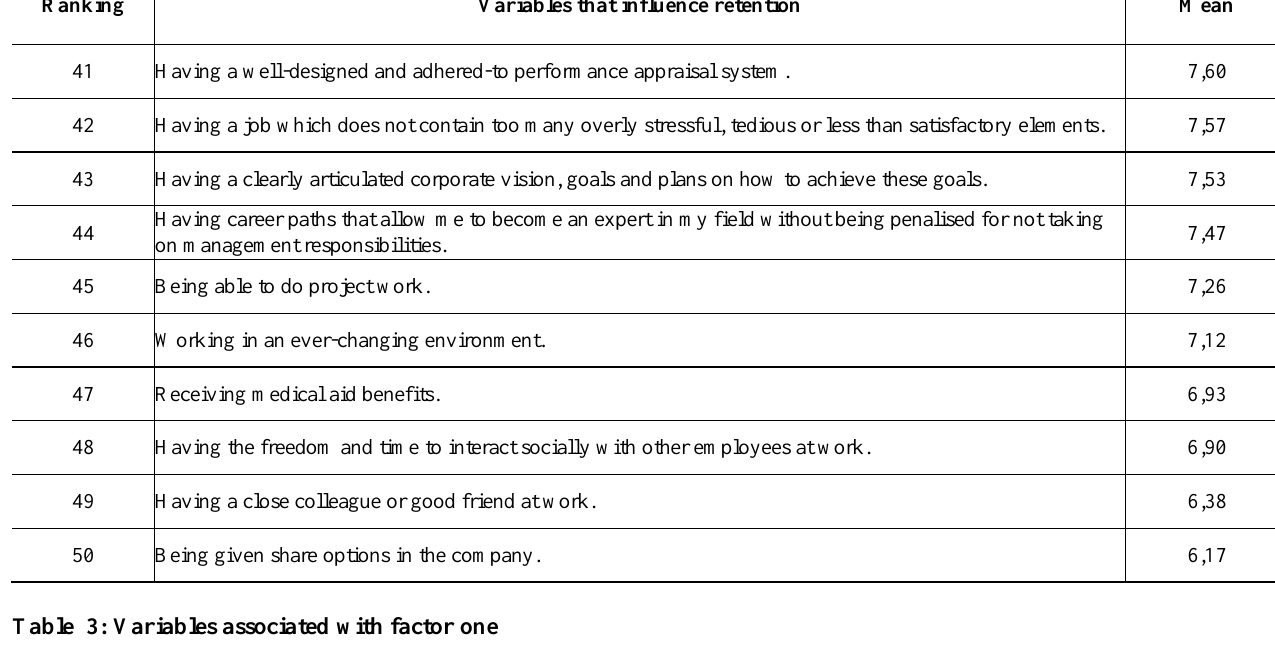
Table 3: Variables associated with factor one